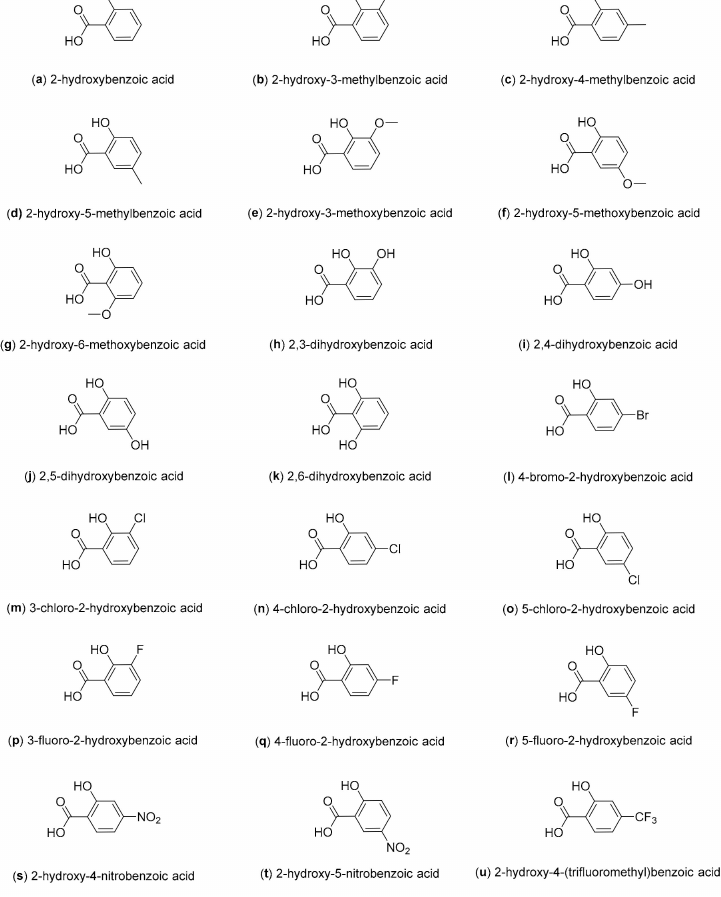
Figure 1. Salicylic acid and 20 substituted